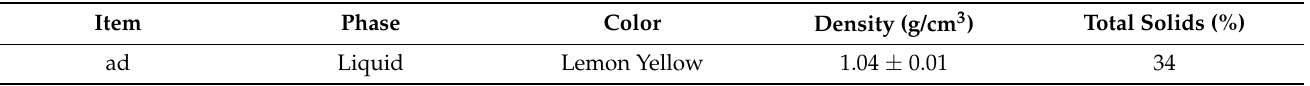
Table 3. Physical properties of chemical